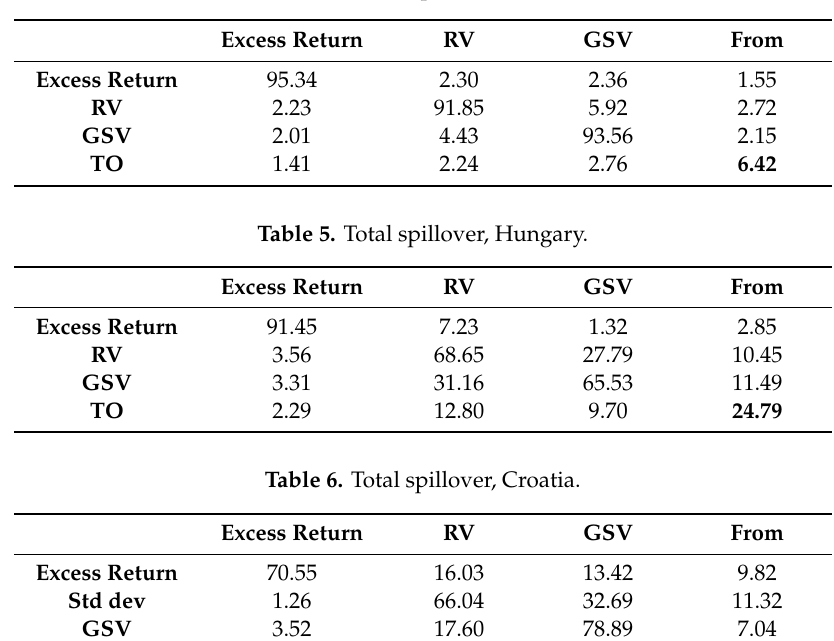
Table 4. Total spillover, Serbia.